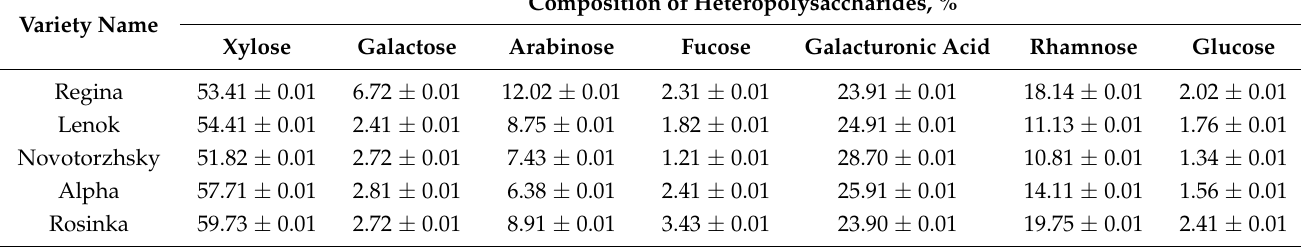
Table 4. Monosaccharide compositions of fiber flax seed mucus samples.